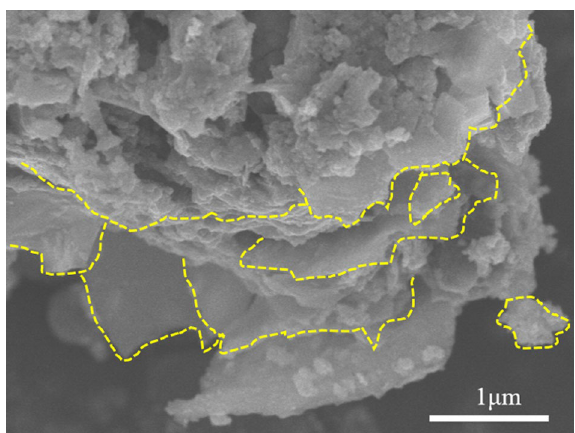
Figure 2. SEM images of Ti 3 C 2 T x MXene micro-nano